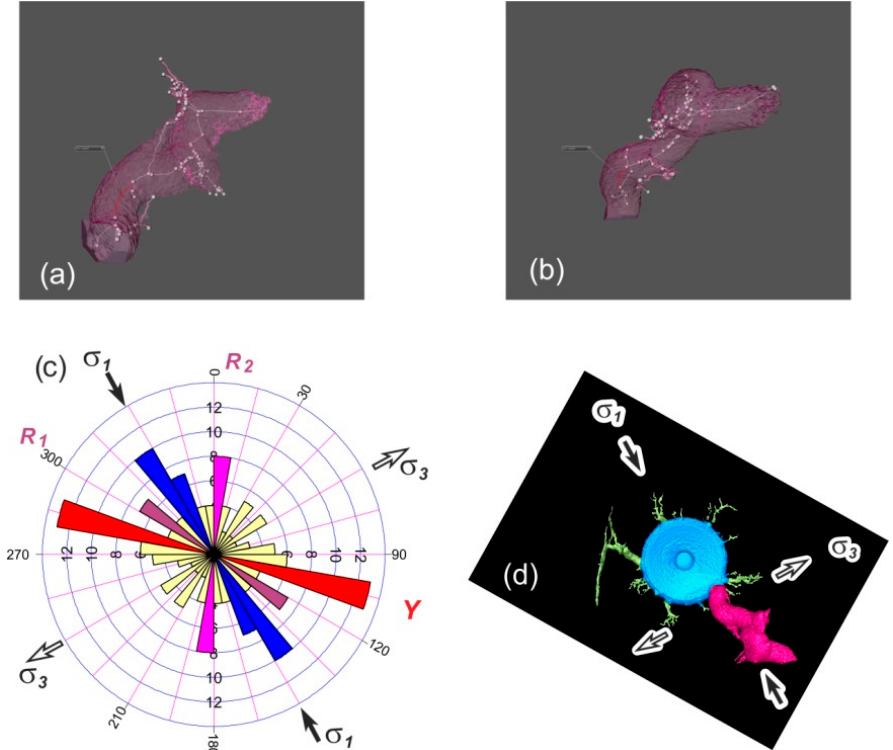
Figure 12. Skeleton model from CT 3D visualization of the principal wormhole represented as the ( a ) bottom and ( b ) vertical view of experiment #7. ( c ) Rose-diagram depicting the preferential directions of the growing principal wormhole, ( d ) which is shown in pink in the top view of the 3D model.